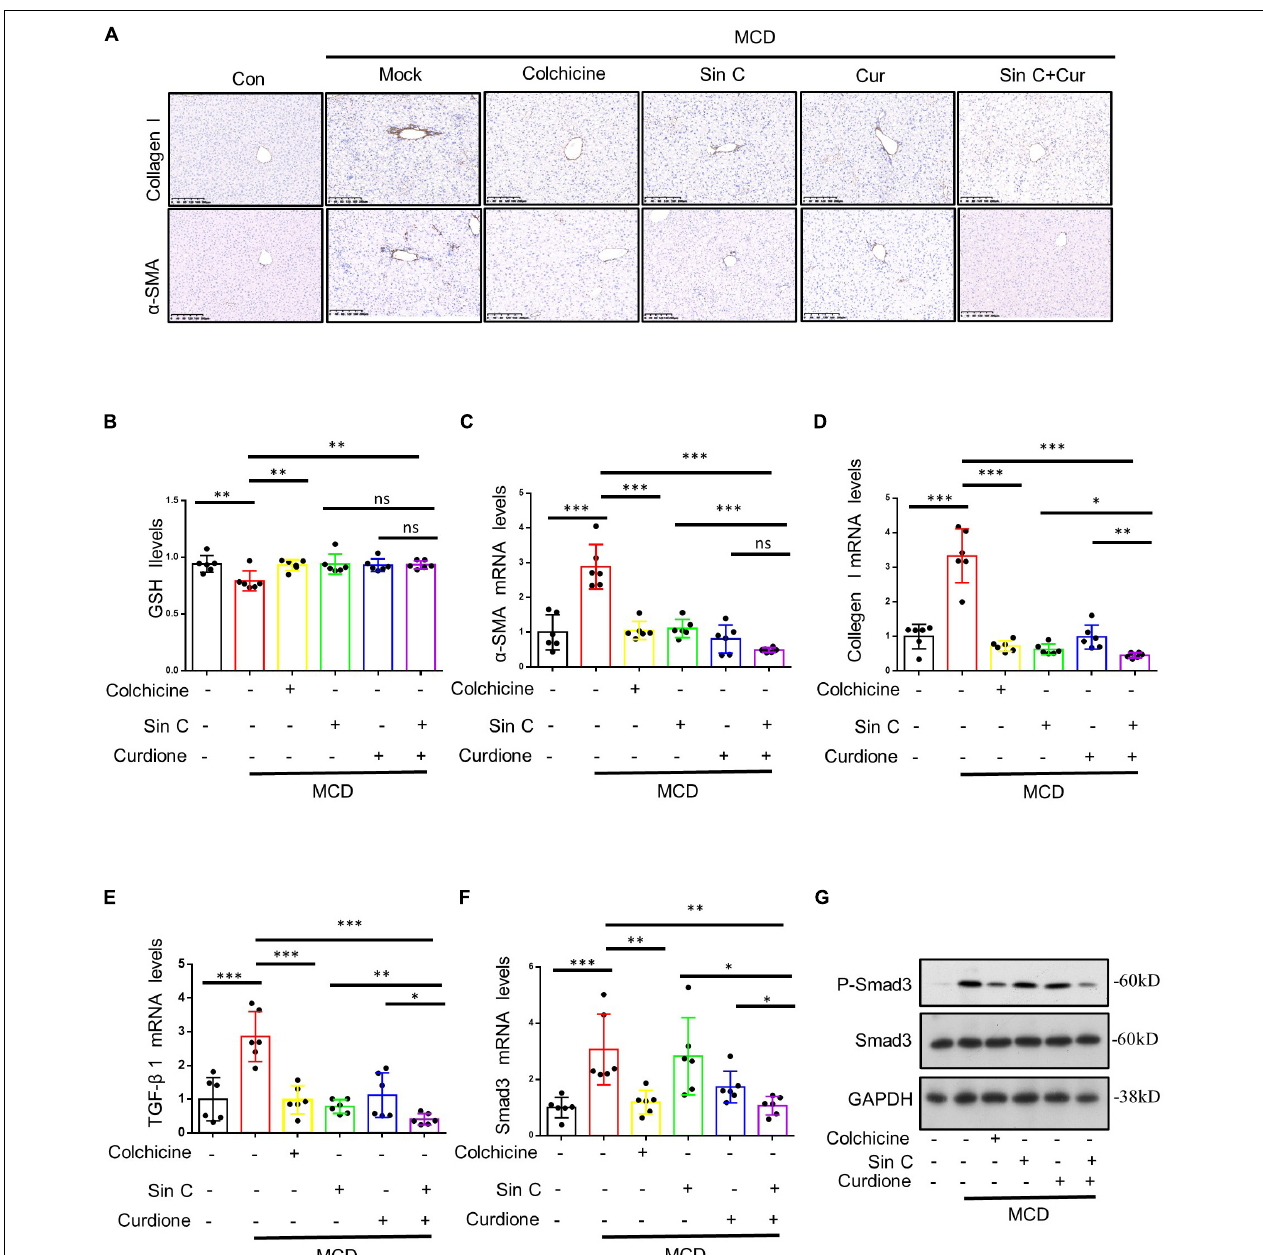
FIGURE 6 | The combination of Sin C and Curdione reduces MCD-induced hepatic fibrosis by regulating the TGF- β 1/Smad pathway and inhibiting oxidative stress. Immunohistochemical staining of α -SMA and collagen I (A) The amount of glutathione (GSH) (B) in liver of mice were measured using commercial ELISA kits. Quantitative polymerase chain reaction (PCR) analysis of mRNA levels of α -SMA, Collagen I, TGF- β 1, and Smad3 (C–F) . Western blot analysis of p-Smad3, Smad3, and GAPDH in livers from control, MCD fed-induced hepatic fibrosis mice, MCD fed-induced hepatic fibrosis mice treated with colchicine (0.2 mg/kg), Sin C (200 mg/kg), Curdione (50 mg/kg) or combination of Curdione and Sin C (G) . Data are expressed as the mean ± SD from six independent mice samples (B–F) , * p < 0.05, ** p < 0.01, and *** p < 0.001; ns, not